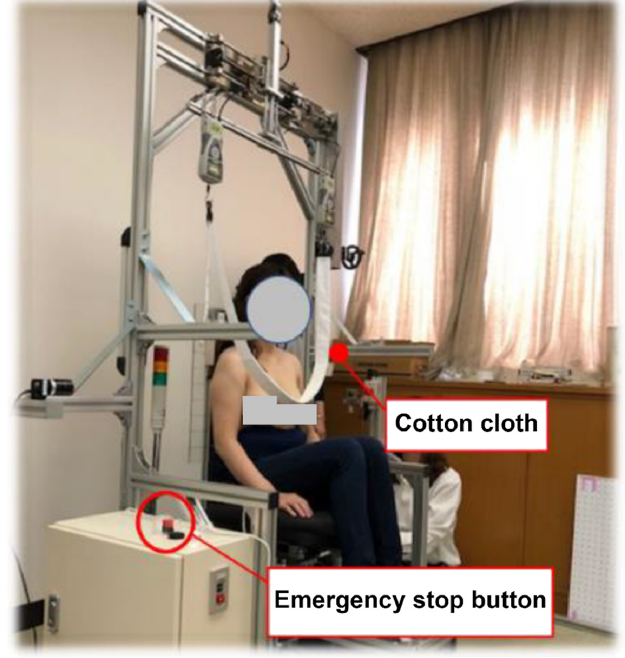
Figure 2. The breast droop value measuring device.